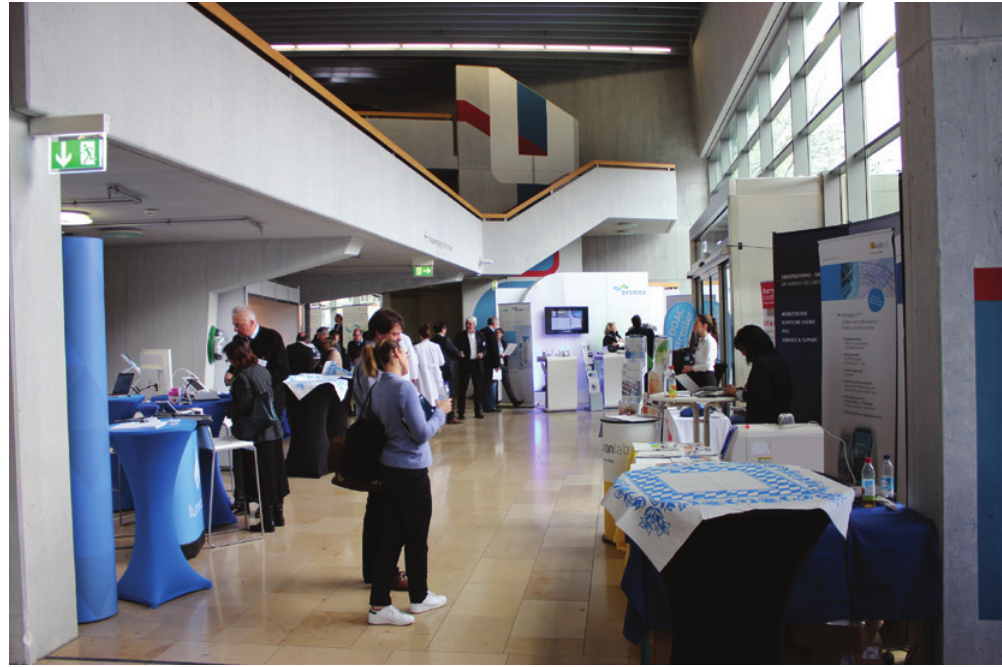
Figure 1: Industrial exhibition at the symposium